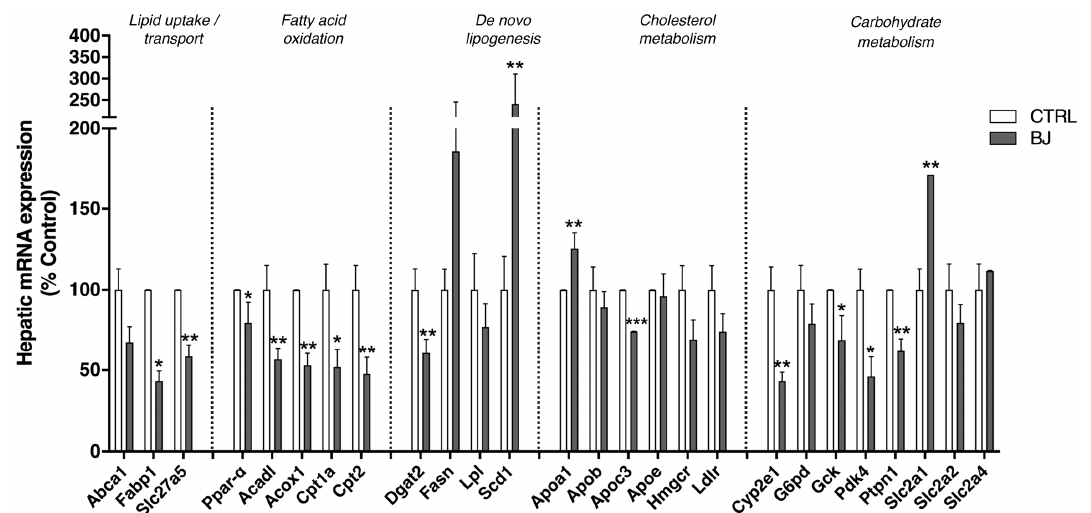
Figure 5. Hepatic mRNA expression of genes involved in fatty acid uptake/transport, fatty acid oxidation, and lipogenesis as well as cholesterol and carbohydrate metabolism. Data are presented ± SEM ( n = 5–6 / group); * p < 0.05, ** p < 0.01, *** p < 0.001 vs. CTRL group. as mean  SEM (n = 5–6/group); * p < 0.05, ** p < 0.01, *** p < 0.001 vs. CTRL group. mean